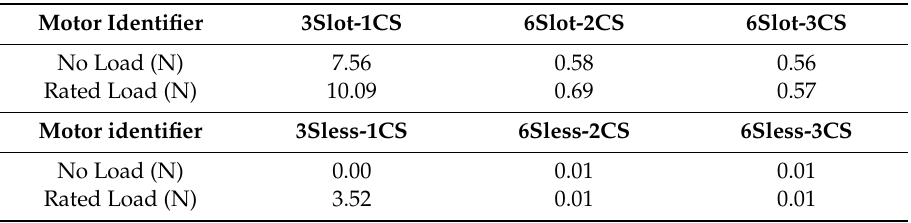
Table 4. Radial force of six analyzed motors under 10% rotor eccentricity.